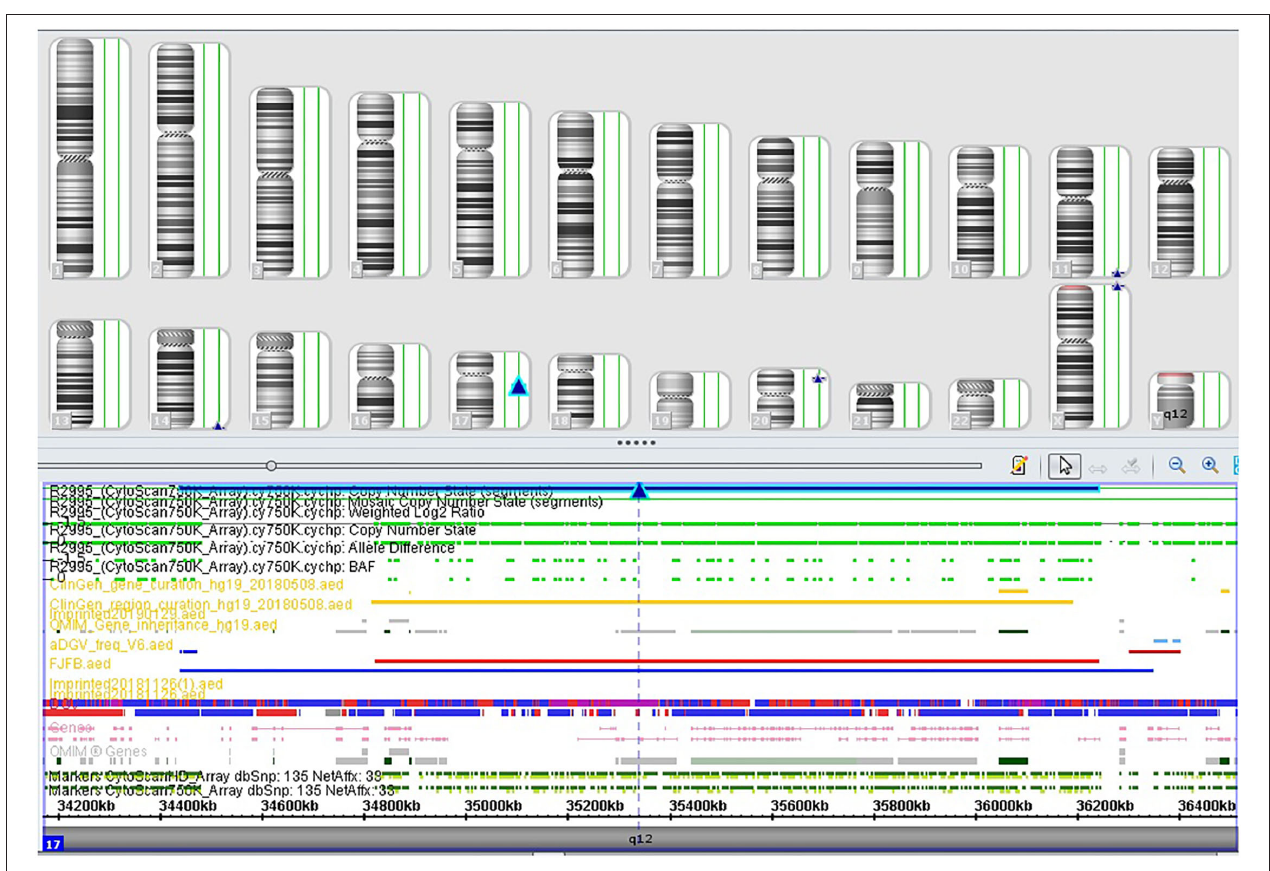
FIGURE 2 | SNP array profile of Case 3. The image indicates a 1.8Mb duplication on 17q12 (34,440,088_36,243,365).